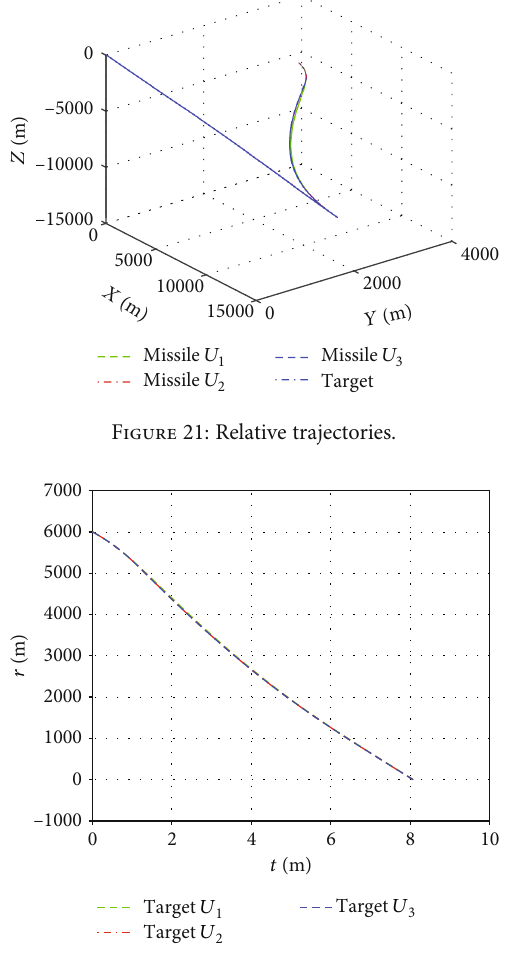
Figure 22: Ranges between the missile and the target.